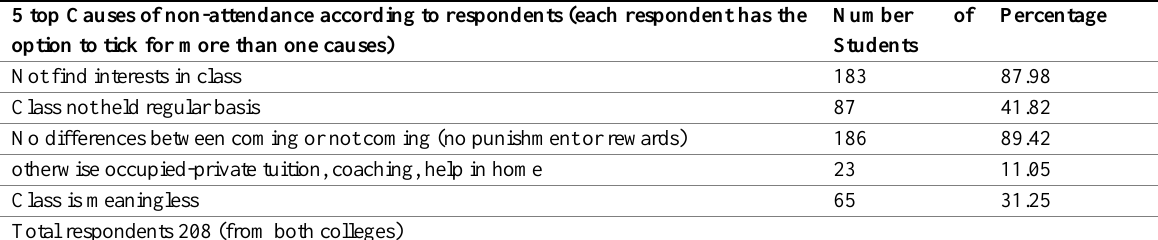
Table 3: Reasons for Non-attendance according to